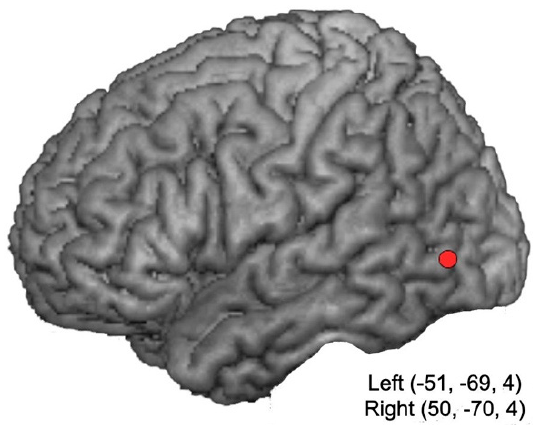
Figure 1. Stimulation sites marked on estimated MRI slices. The mean Talairach coordinates fell within the posterior part of the middle temporal gyrus (Brodmann’s area 37) for the left and right lateral occipitotemporal cortex.